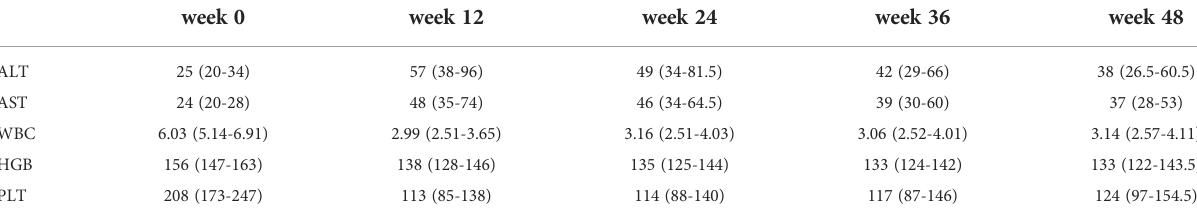
TABLE 3 Changes of liver function and blood routine